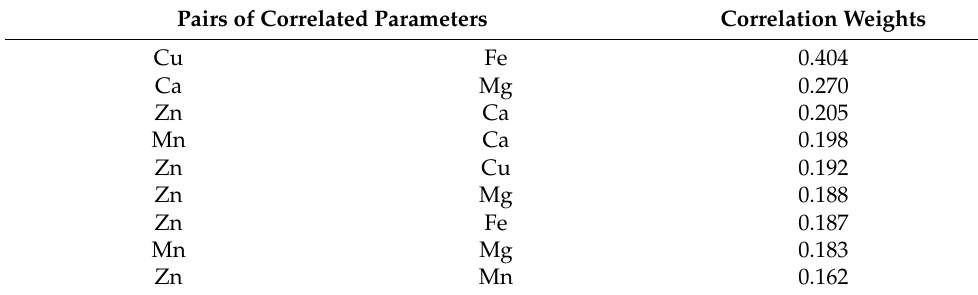
Table 2. Correlation weights based on principal components in the PCA model (only correlation weights with absolute values higher than 0.100 are shown).